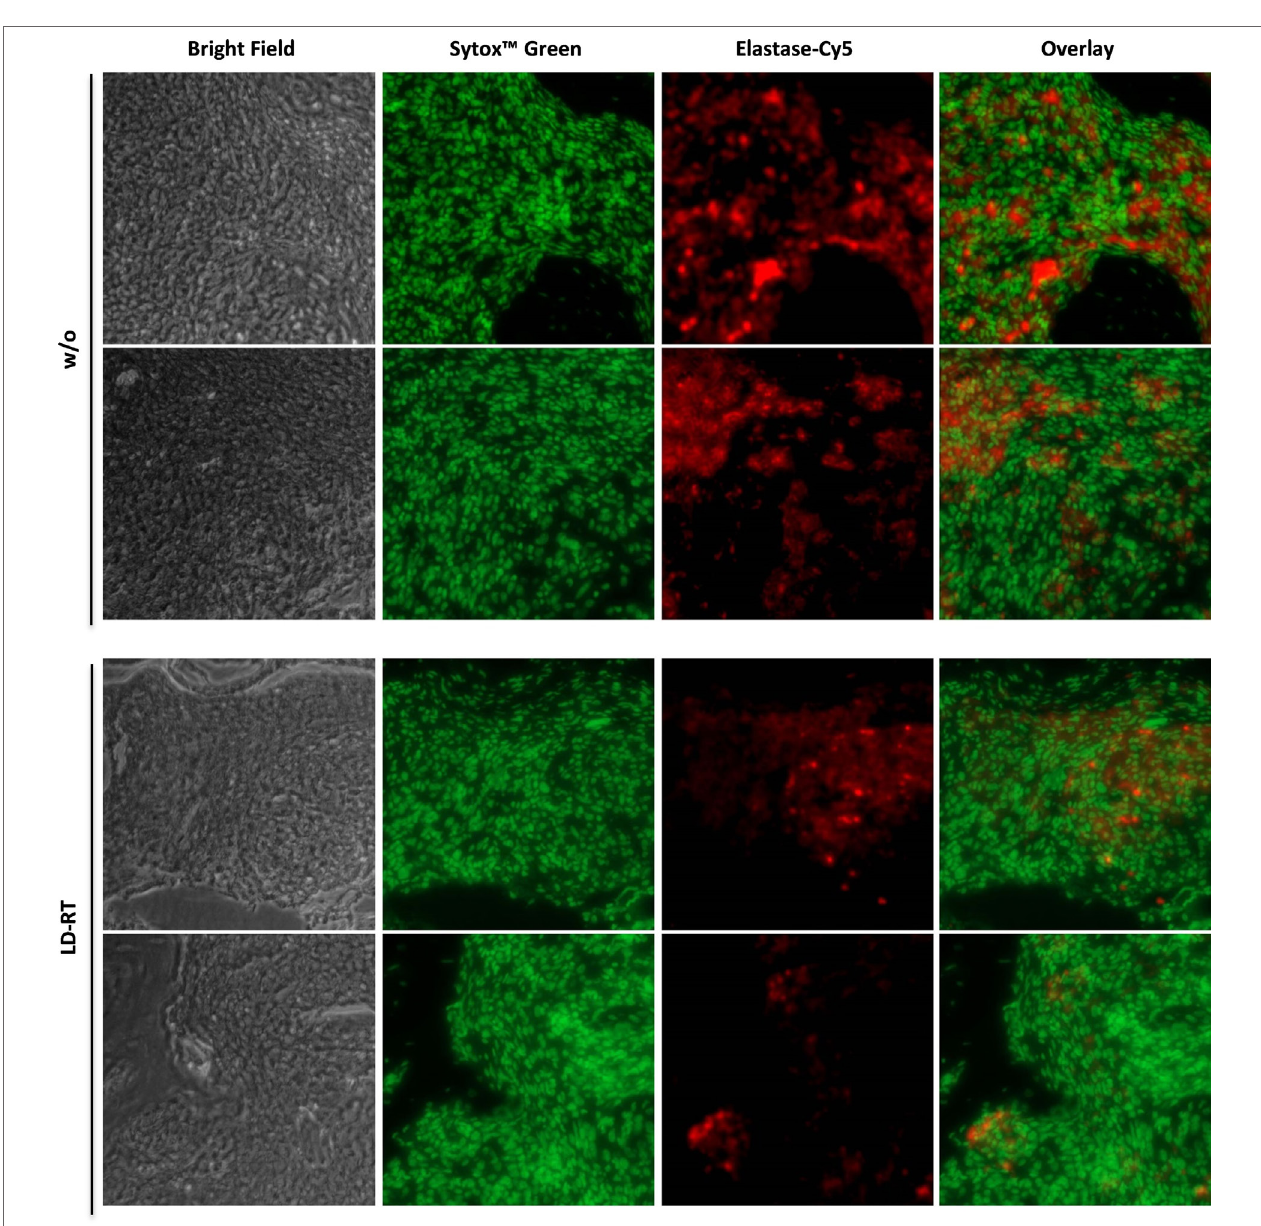
FigUre 6 | Low-dose irradiation impacts on neutrophil infiltration and neutrophil extracellular trap formation. 8-week-old h TNF- α tg mice suffering from established polyarthritis (PA) were locally irradiated with 0.5 Gy of X-rays. Sham-irradiated (w/o) mice served as control animals. 33 days post-irradiation, animals were sacrificed and hind paws were decalcified and embedded in paraffin. Sections of embedded paws were stained for elastase-Cy5 and sytox ™ green. Pictures were randomly taken at 20 × magnification using a Zeiss microscope. Exemplary images from two mice per treatment are depicted.